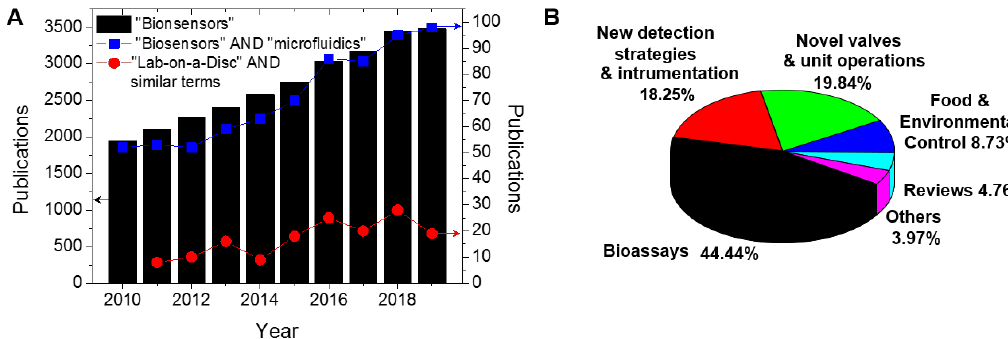
Figure 1. Web of Science results analysis by publication year using the topic ( A ) “biosensors” (black bars), the combination of “biosensors” and “microfluidics” (connected blue squares), and the terms “lab-on-a-disc” or “lab-on-a-CD” or “bio-disk” or “lab-CD” or “lab-disc” (connected red circles). ( B ) “lab-on-a-disc” results distributed in applications focus. Data from Clarivate Analytics (ISI Web